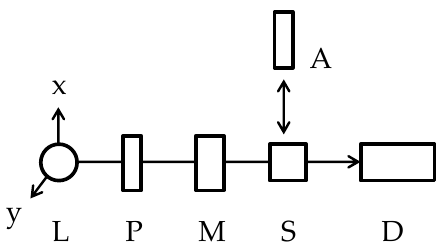
Figure A1. Block diagram of the CD measurement system, which consists of a light source (L), monochromatic filter (F), polarizer (P), phase modulator (M), sample (P), analyzer (A), and photo detector (D).